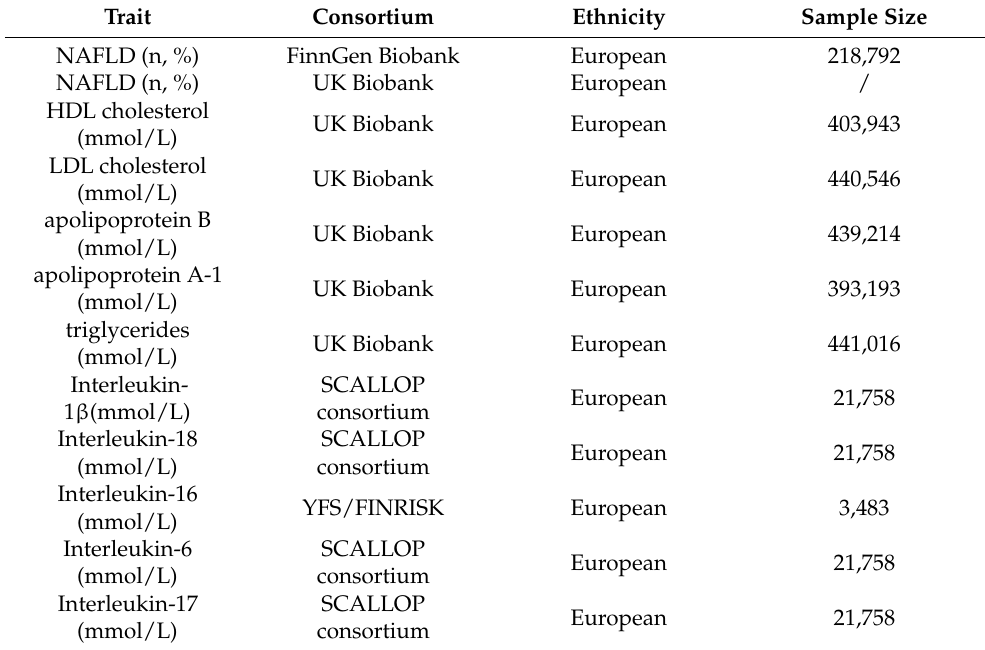
Table 1. Details of GWAS included in Mendelian randomization